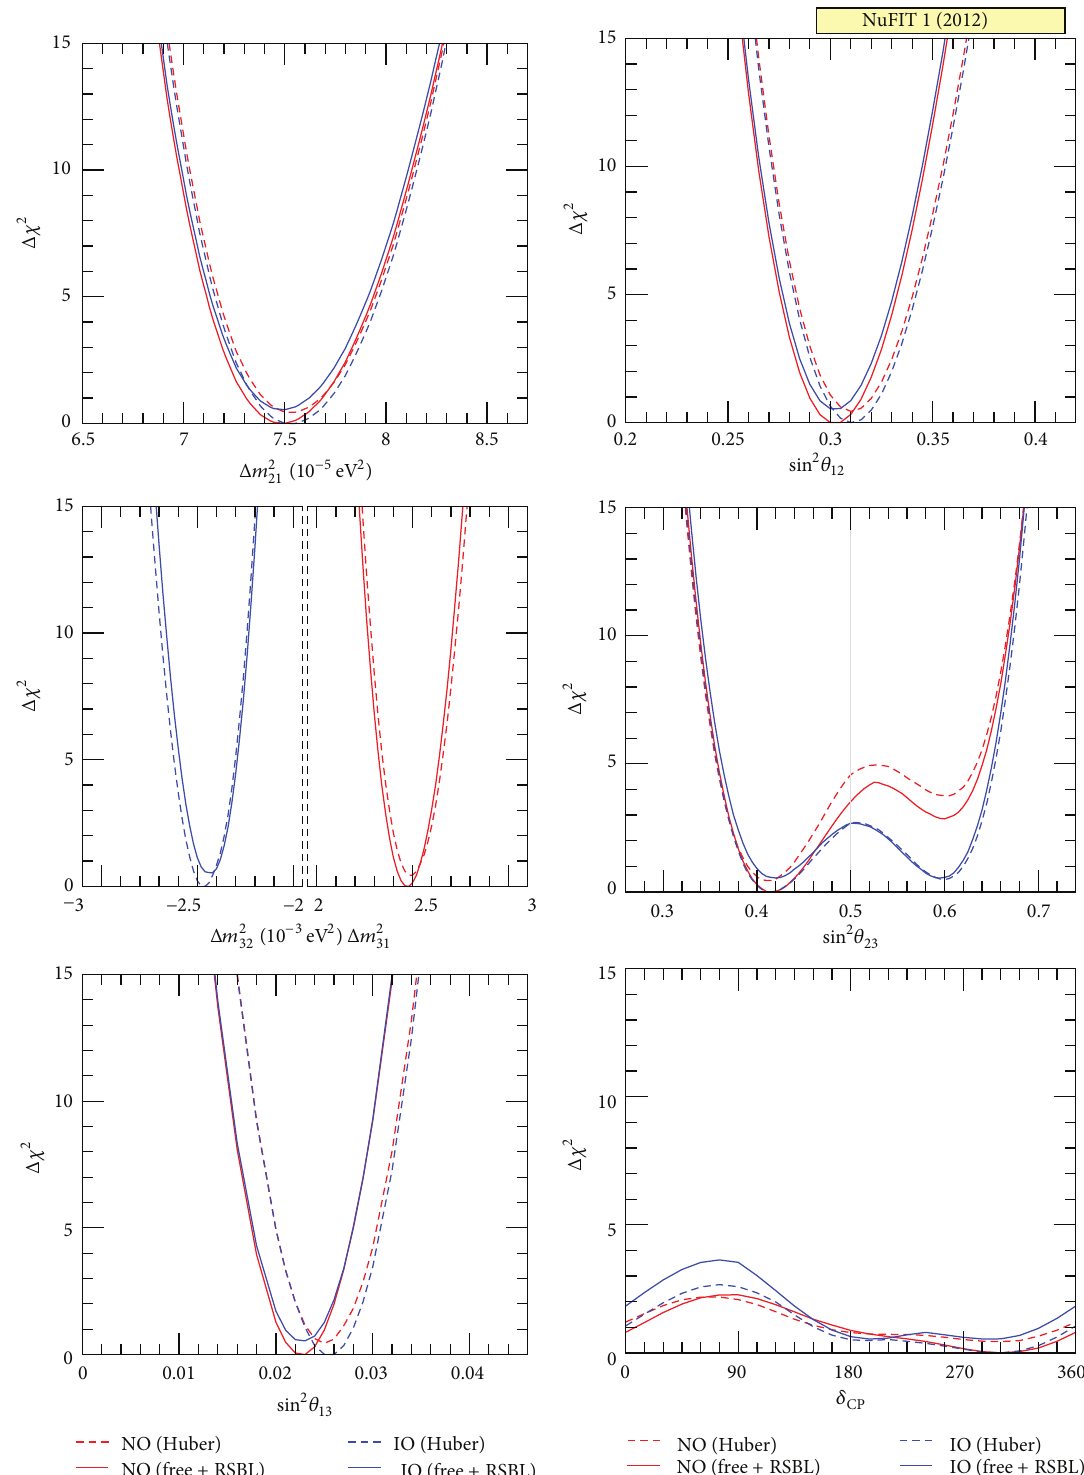
Figure 1: Determination of three-flavour oscillation parameters [10]. The red (blue) curves are for NH (IH). Results for different assumptions concerning the analysis of data from reactor experiments are shown: for solid curves the normalization of reactor fluxes is left free, and data from short-baseline (less than 100m) reactor experiments are included. For dashed curves short-baseline data are not included but reactor fluxes as predicted in [152] are